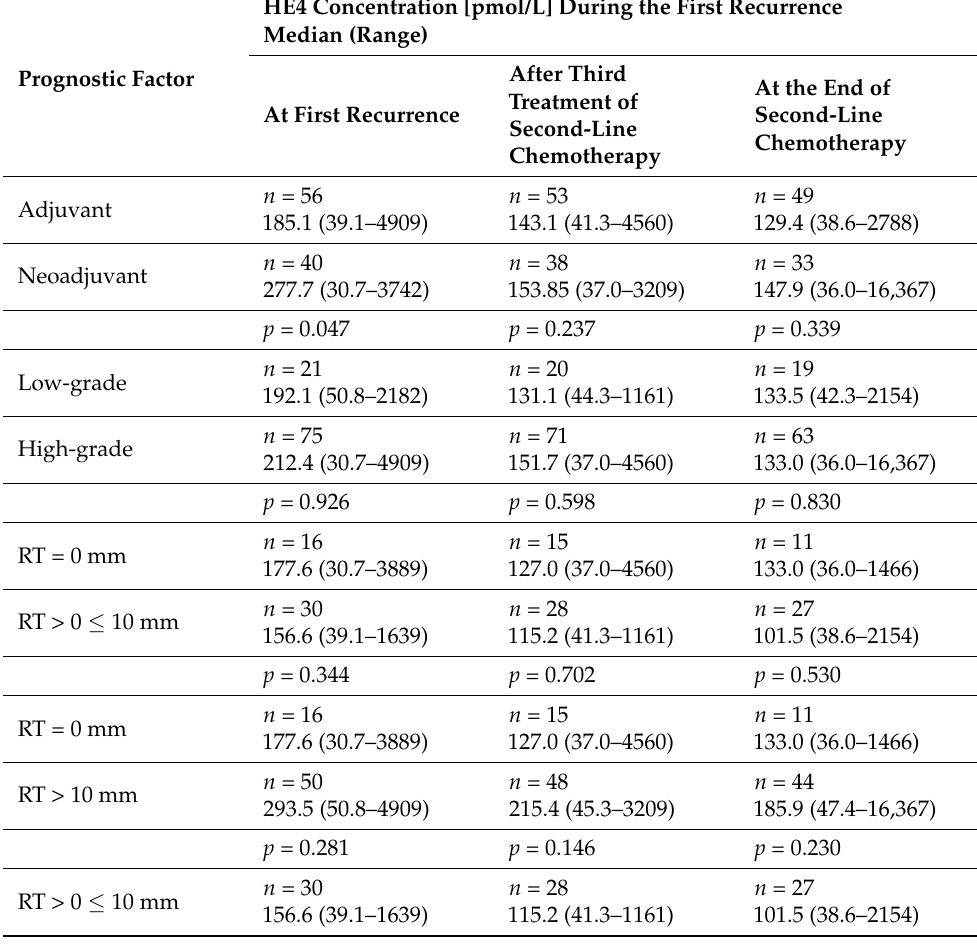
Table 3. Distribution of HE4 during at the time of OC recurrence diagnosis and